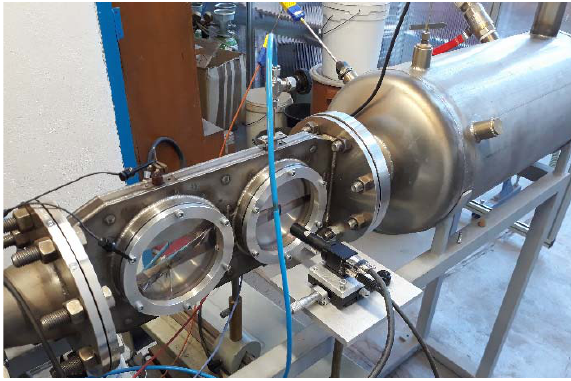
Fig. 1. Wind tunnel test section with